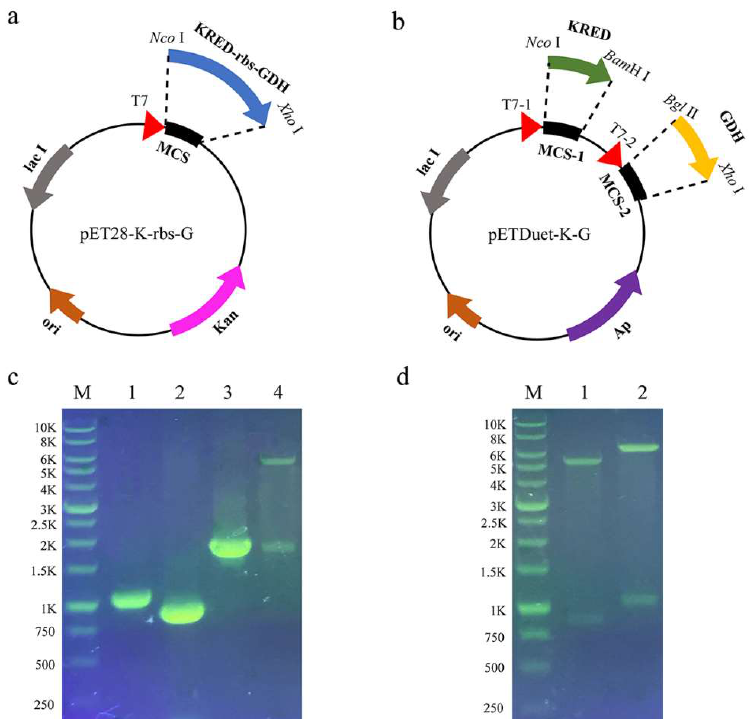
Figure 1. Schematic representation and identification of the coexpression recombinant